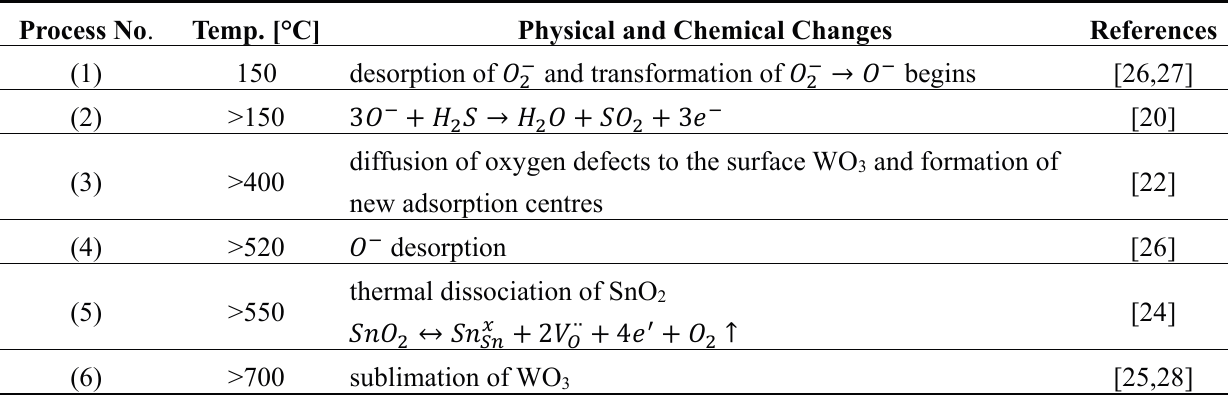
Table 1. Physical and chemical changes of tin dioxide/tungsten trioxide due to adsorption of oxygen or water on its surface.